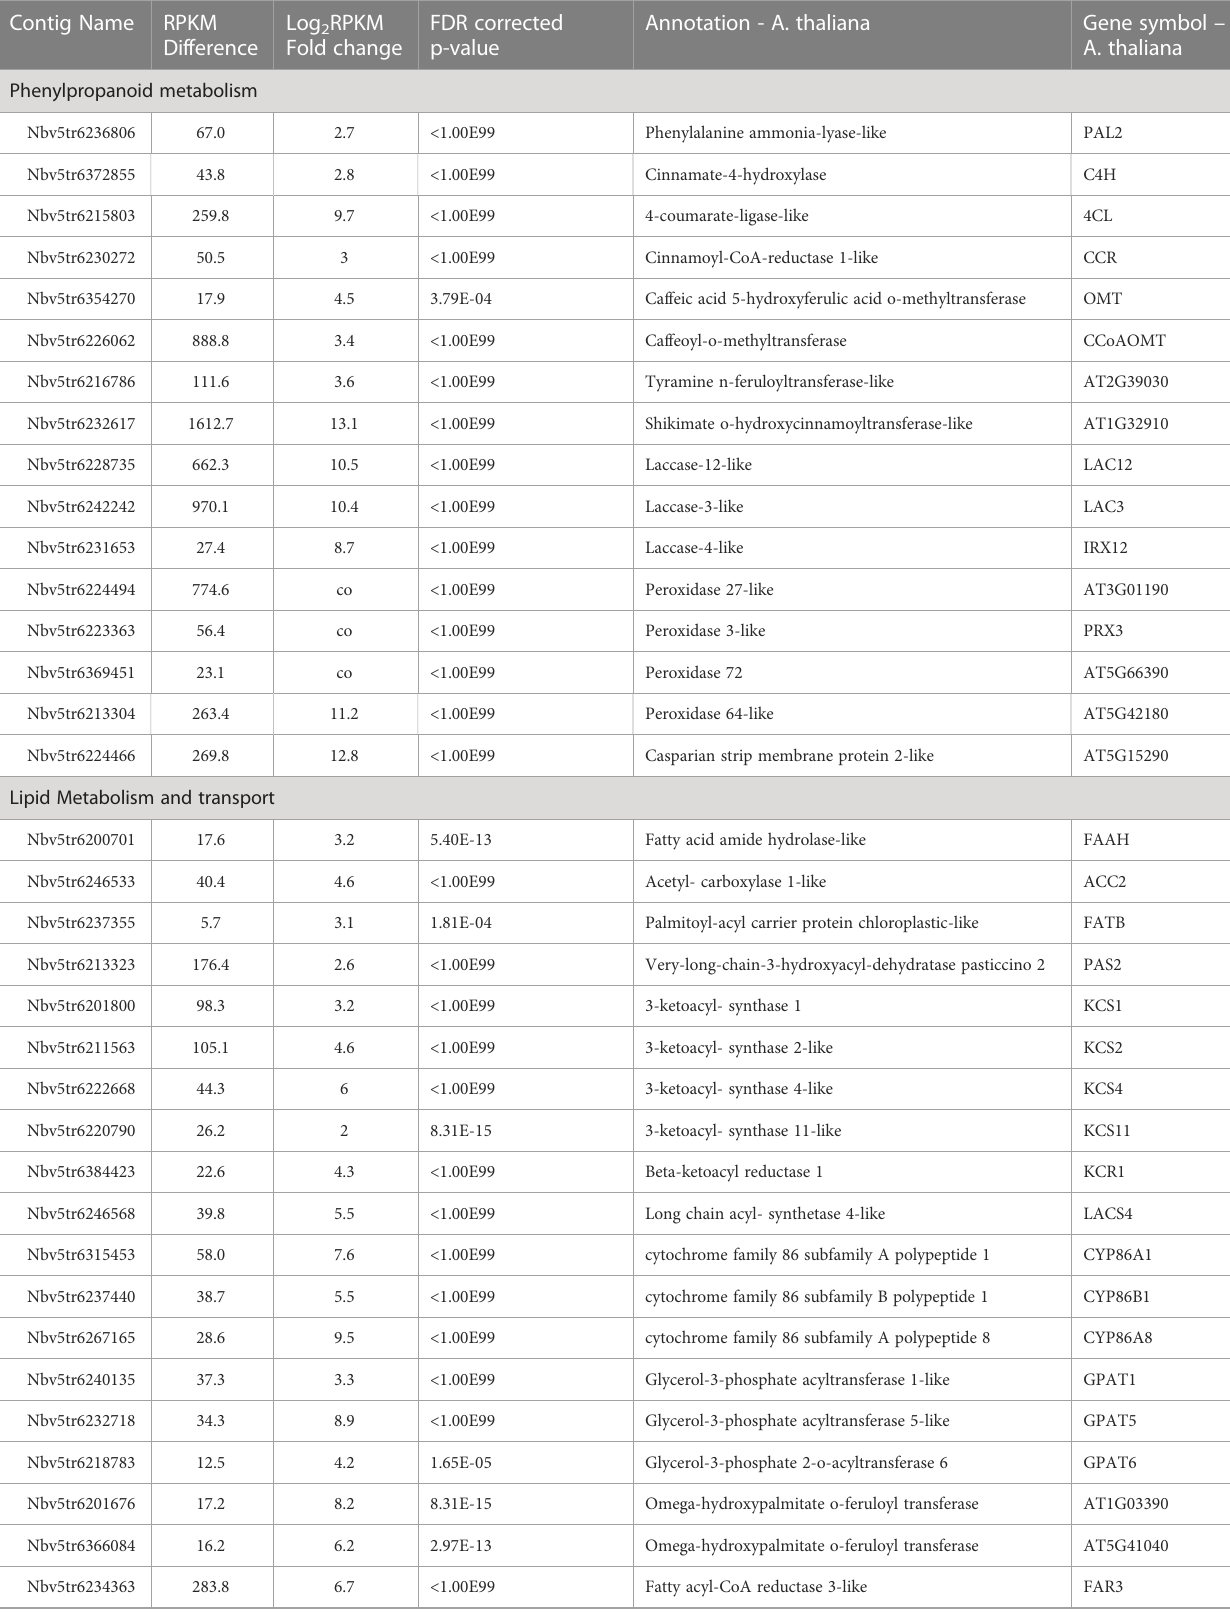
TABLE 1 Selection of the differentially expressed genes obtained from the statistical comparison of N. benthamiana leaves in fi ltrated with the MYB68 construct versus leaves in fi ltration with empty vector construct 4 days after in fi